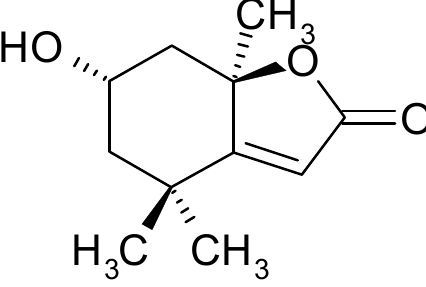
Figure 1. Structure of loliolide.